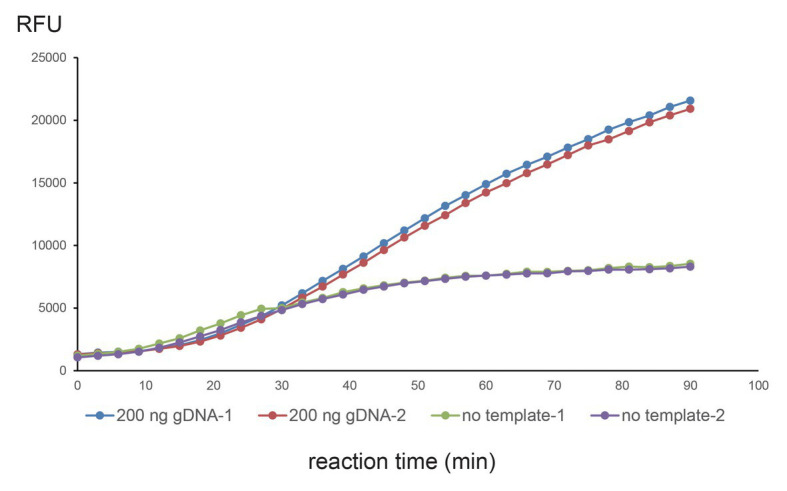
Single-tube one-step CNAD reaction using 200-ng gDNA. WT crDNA with two additional mismatches at seventh and ninth positions was used to detect WT mitochondrial DNA. Two hundred nanograms of genomic DNA or no template control was tested and repeated twice. Fluorescence (RFU) vs. reaction time was plotted. Each dot represents a fluorescence reading.